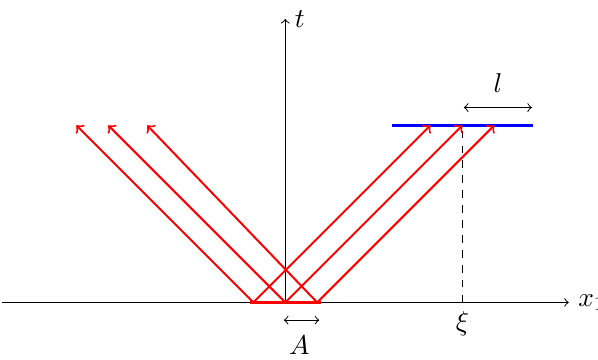
Figure 11 : In the quasiparticle model, the quench creates EPR pairs of entangled quasi- particles which subsequently propagate without interactions. When just one of the quasi- particles belonging to an EPR pair is inside the blue region, the entanglement entropy of the region